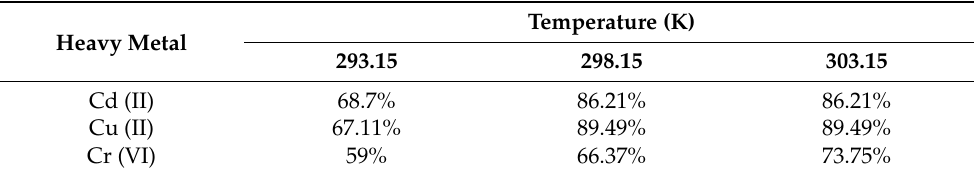
Table 4. Efficiencies of each metal varying temperature.